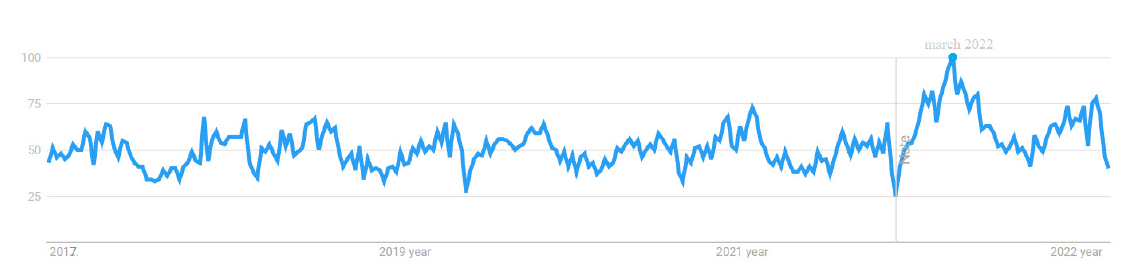
Figure 2. Google Trends on public debt worldwide in 2017–October,